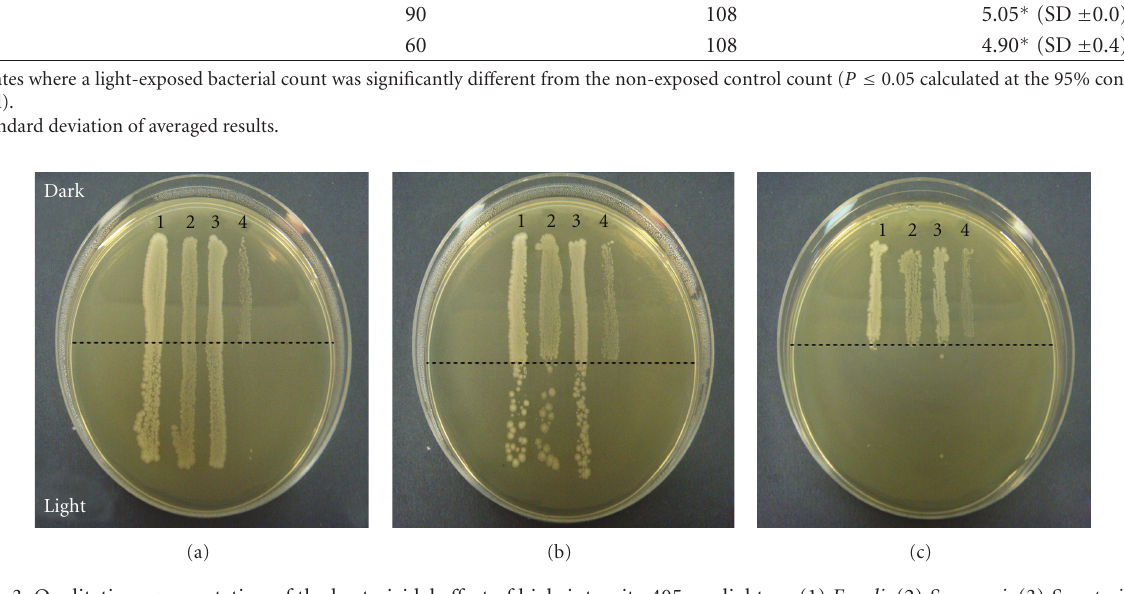
Figure 3: Qualitative representation of the bactericidal e ff ect of high-intensity 405 nm light on (1) E. coli , (2) S. sonnei, (3) S. enterica, and (4) L. monocytogenes. Plates (a), (b), and (c) demonstrate the inactivating e ff ect of 15, 30, and 45 minutes light exposure, respectively, on streaks of the foodborne pathogenic bacteria, with half of each plate being light exposed and the other half being kept in darkness to provide the equivalent non-light-exposed